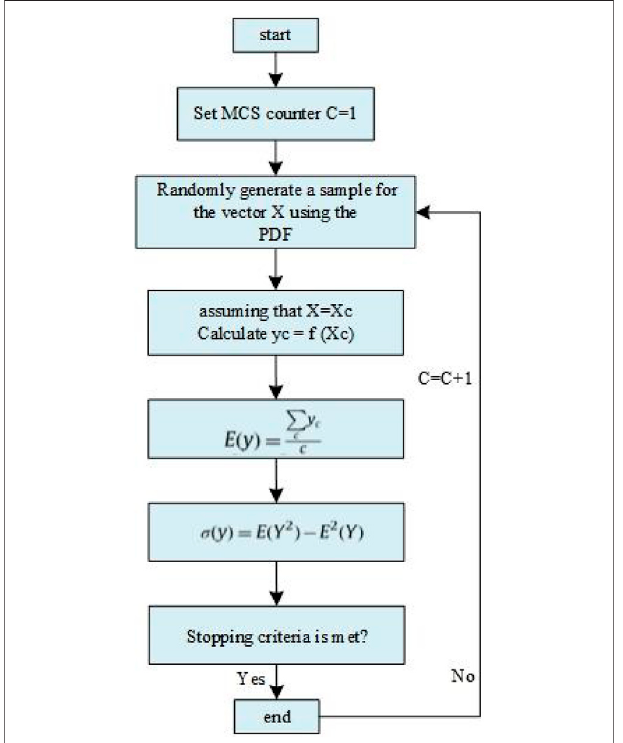
FIGURE 3 | The calculation process of